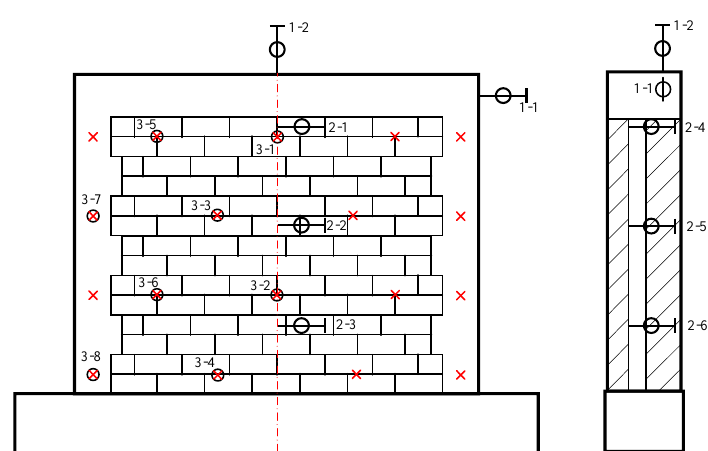
Figure 5. Load and displacement sensor arrangement (1-1,1-2. Load and displacement sensor; 2-1–2-6. Displacement sensor; 3-1–3-8. Strain gauge).